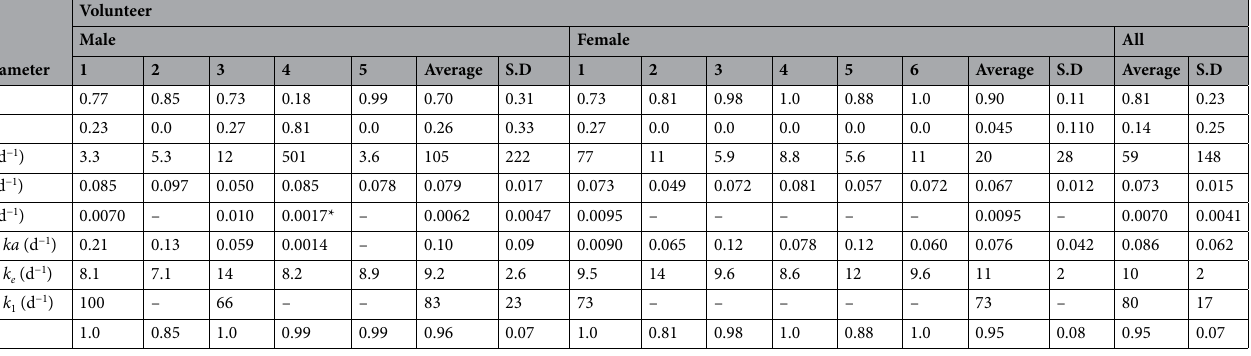
Table 2. Estimated parameters of OBD model for each volunteer administered with D-labelled glucose. S.D., standard deviation. k